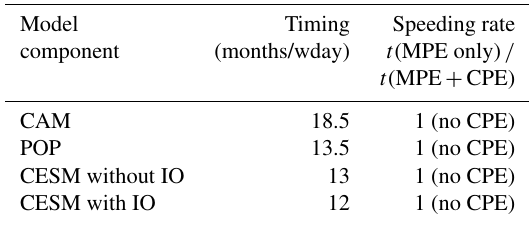
Table 3. Timing of the CESM-HR on Sunway MPEs. Table 4. Results of the ECT tests for the Sunway MPE-only CESM- HR version with different compiling optimization